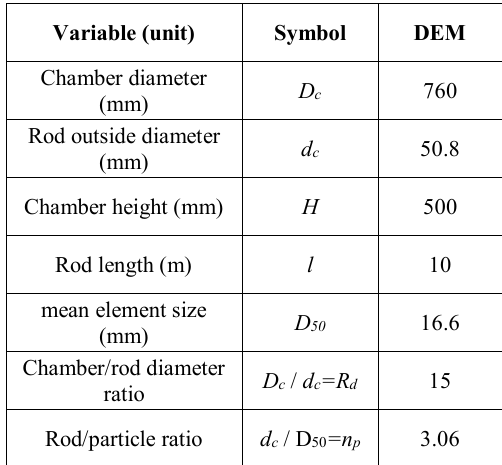
Table 2. Geometrical characteristics of the virtual calibration chamber.